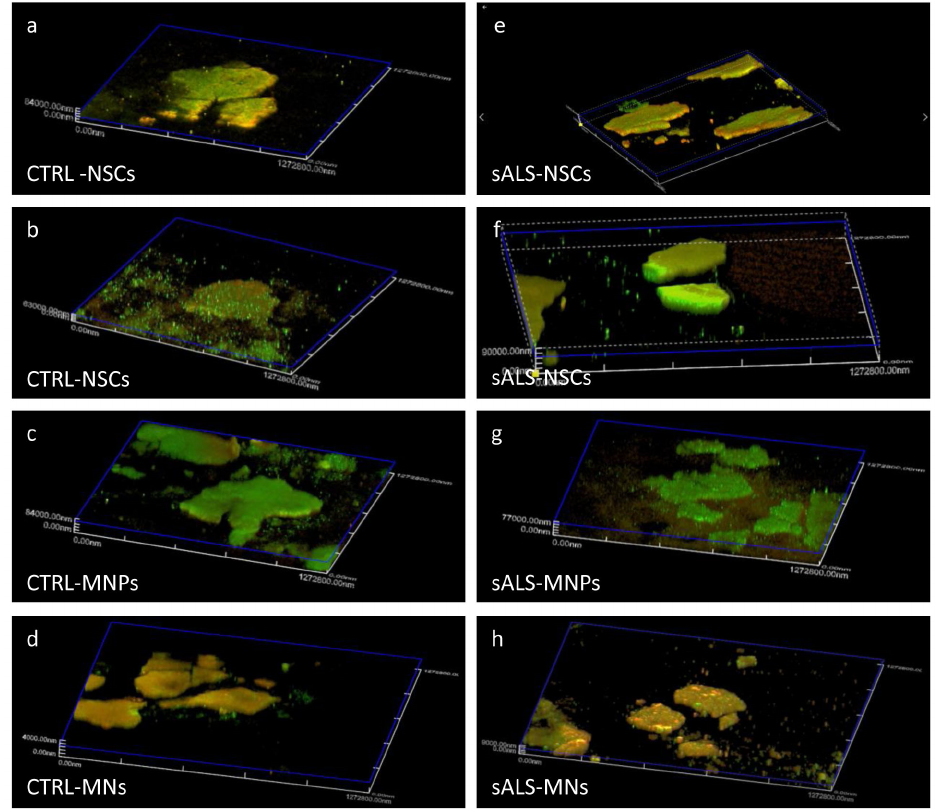
Figure 2. Cells express the typical markers of each stage of differentiation in 3D bioprinting. NSCs differentiated from induced pluripotent stem cells (iPSCs) of control (CTRL), and sporadic amyotrophic lateral sclerosis (sALS) subjects were grown into Cellink Bioink (IK-102000; Cellink, Gothenburg, Sweden) and differentiated into MNPs and MNs. Cells express the typical markers of every differentiation step: ( a , e ) NSCs: Nestin = green and SOX2 = red; ( b , f ) NSCs: SOX1 = green and PAX6 = red; ( c , g ) MNPs: Olig2 = green and PAX6 = red and ( d , h ) MNs: TUBB3 = green and Chat = red. The images were taken from videos acquired through confocal microscopy (Olympus Fluoview, FV10i, Tokyo, Japan).